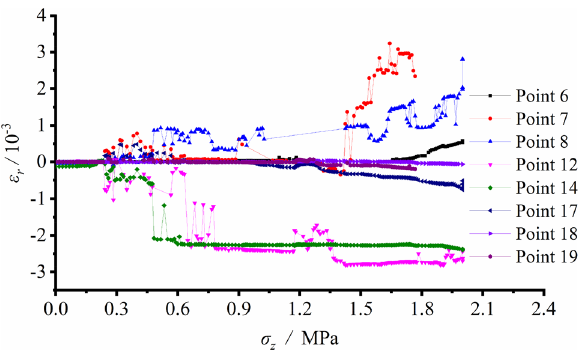
Figure 8. Radial strain variation vs. vertical load at each measuring spot around the tunnel during